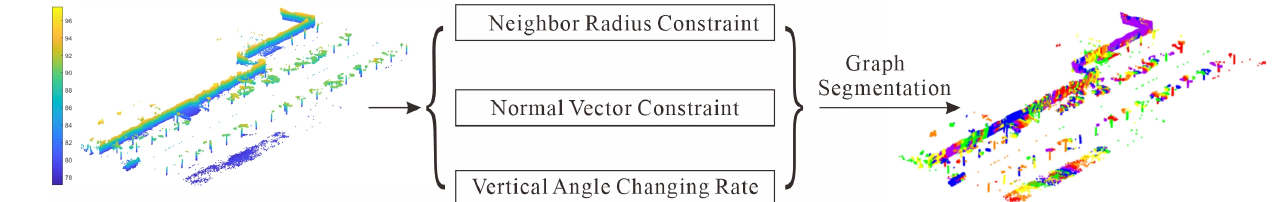
Figure 2. Graph segmentation. The left figure shows the points colored according to the elevation before segmentation. The right figure shows the result of segmentation; different object primitives have different colors.